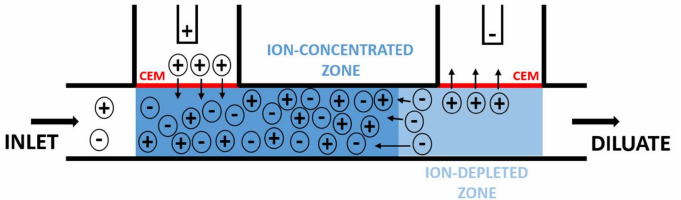
Figure 1. The principle of the chip operation: the passing current sustains the developed ion-depleted and ion-concentrated zones. The electric current is borne by ionic counterions, that is, cations in the case of cation-exchange